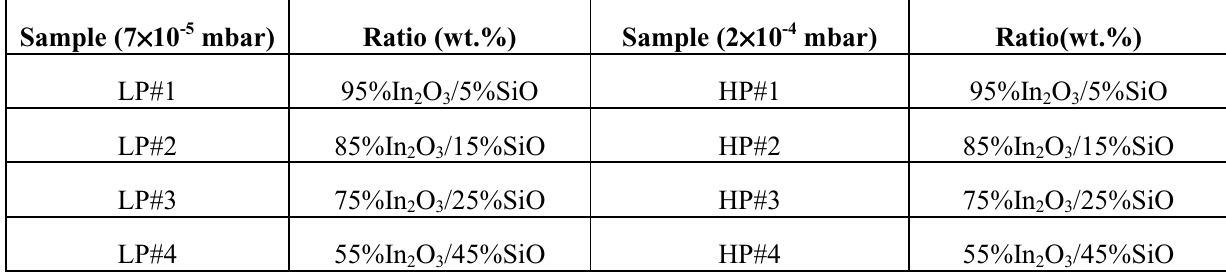
Table 1. Summary of the different sensor samples produced at low and high vacuum